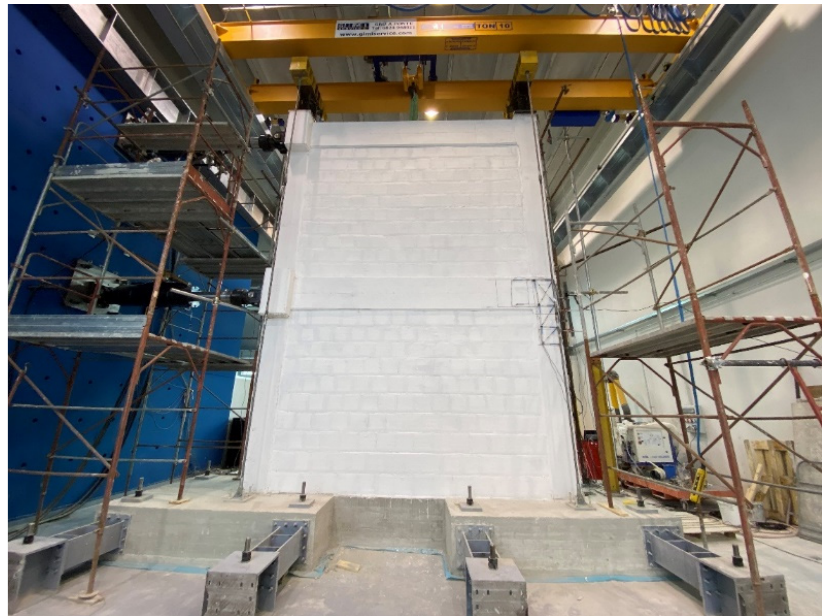
Figure 1. Front view of one full-sale RC frame with the pseudo-dynamic test setup.